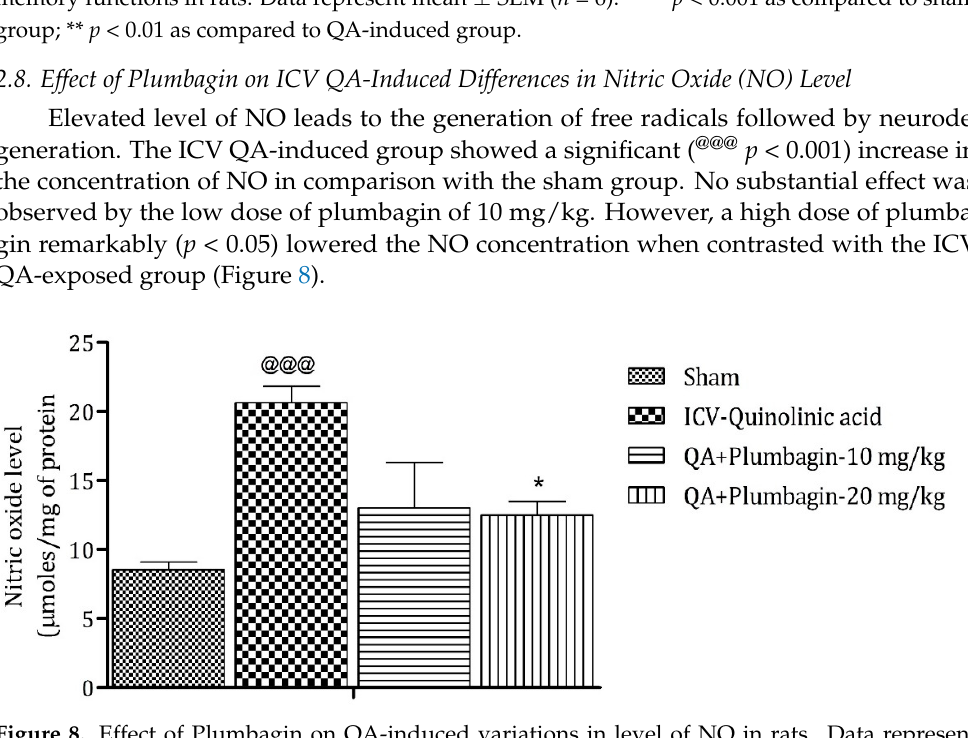
Figure 8. Effect of Plumbagin on QA-induced variations in level of NO in rats. Data represent mean ± SEM ( n = 6). @@@ p < 0.001 as compared to sham group; * p < 0.05 as compared to QA-induced group.